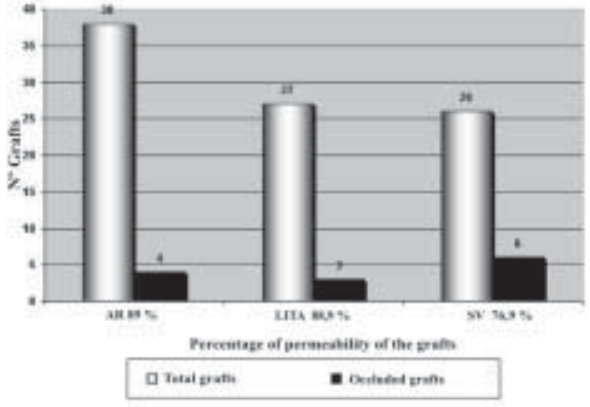
Fig. 2 - Result of the patency of the grafts in the late restudy